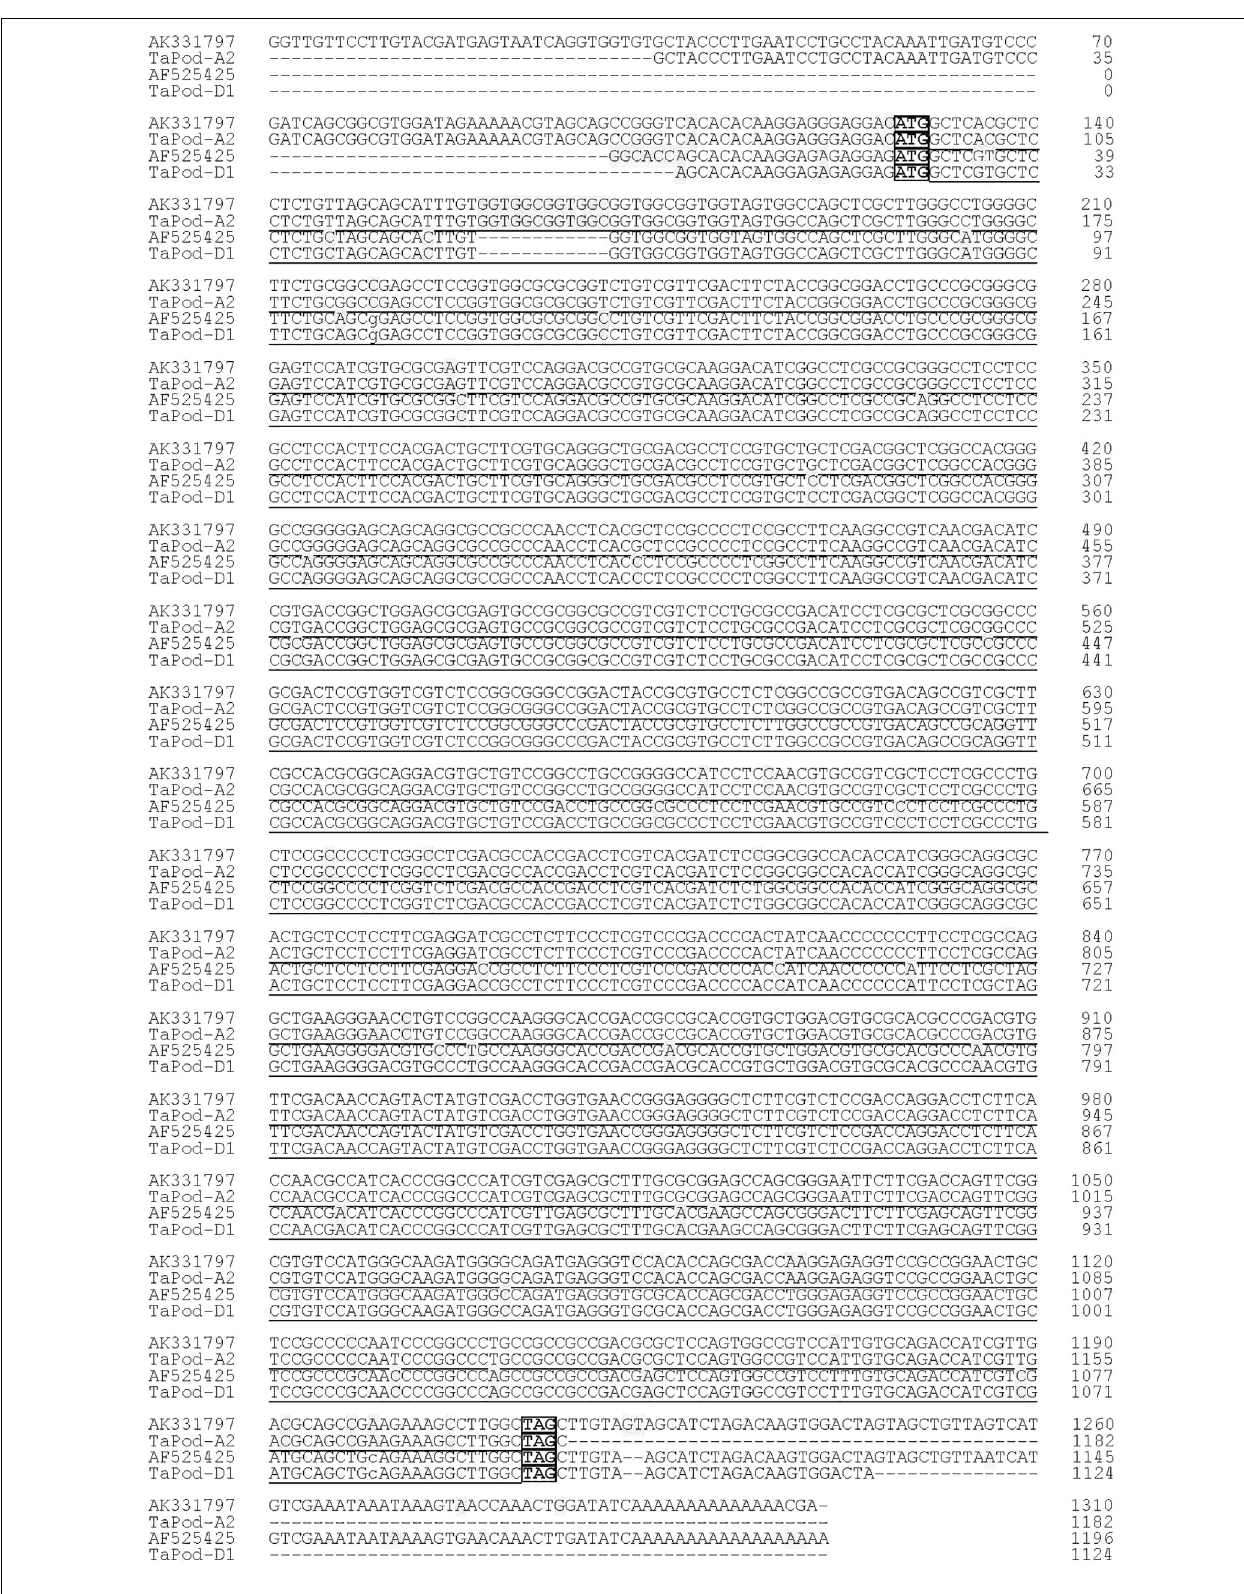
FIGURE 1 | Alignment of TaPod-D1 and TaPod-A2 . The SNPs are shaded , whereas the exons are underlined . The start and terminate codons are in boxes. Hyphens indicate gaps to improve alignment.